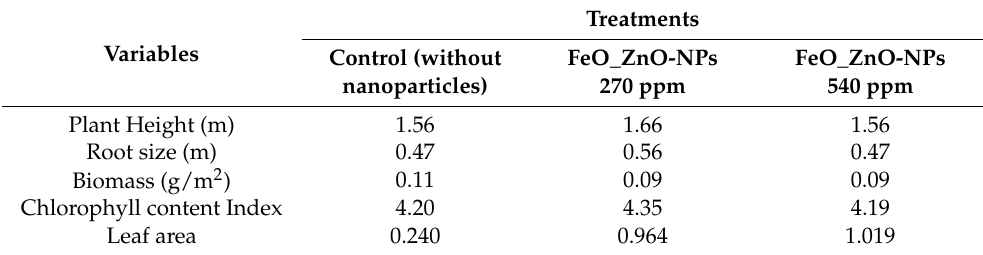
Table 6. Effect of FeO_ZnO-NPs on growth of Andean lupin ( Lupinus mutabilis Sweet), var. I-450